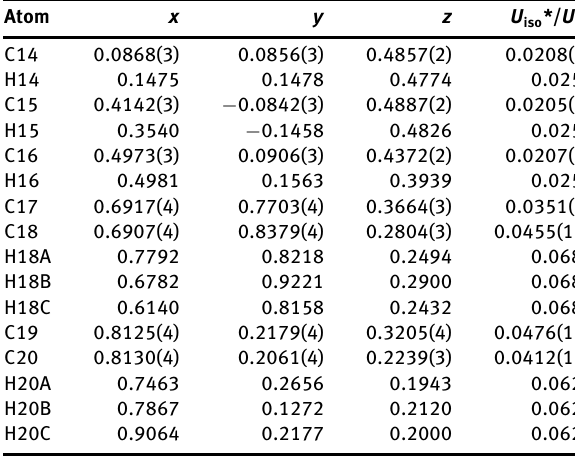
Table 2: Fractional atomic coordinates and isotropic or equivalent isotropic displacement parameters (Å 2